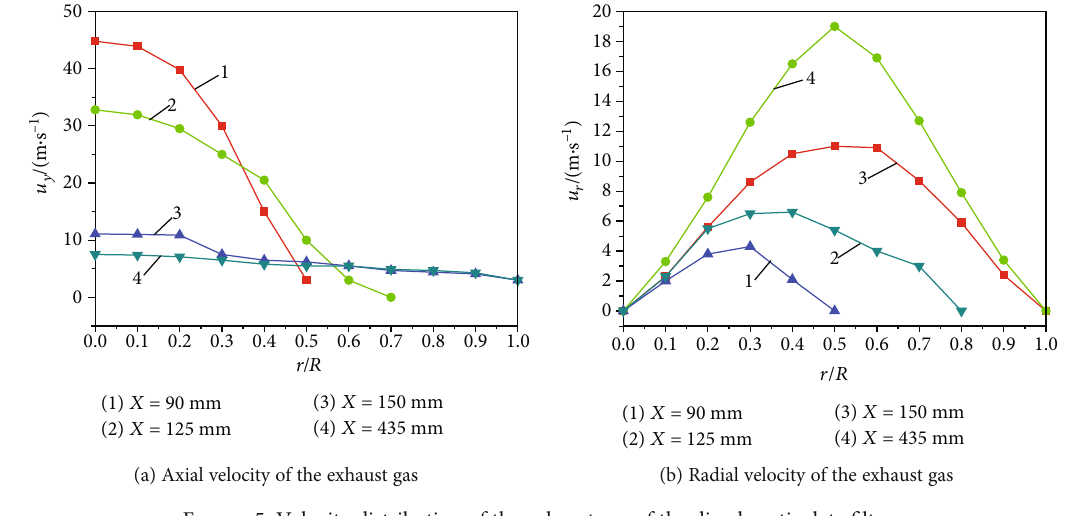
Figure 5: Velocity distribution of the exhaust gas of the diesel particulate fi lter.